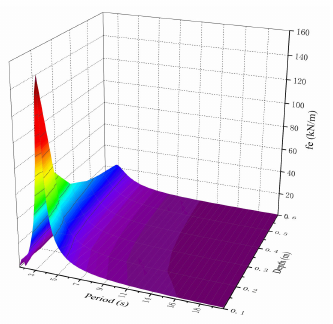
Figure 8. Change of excitation force at different submerged